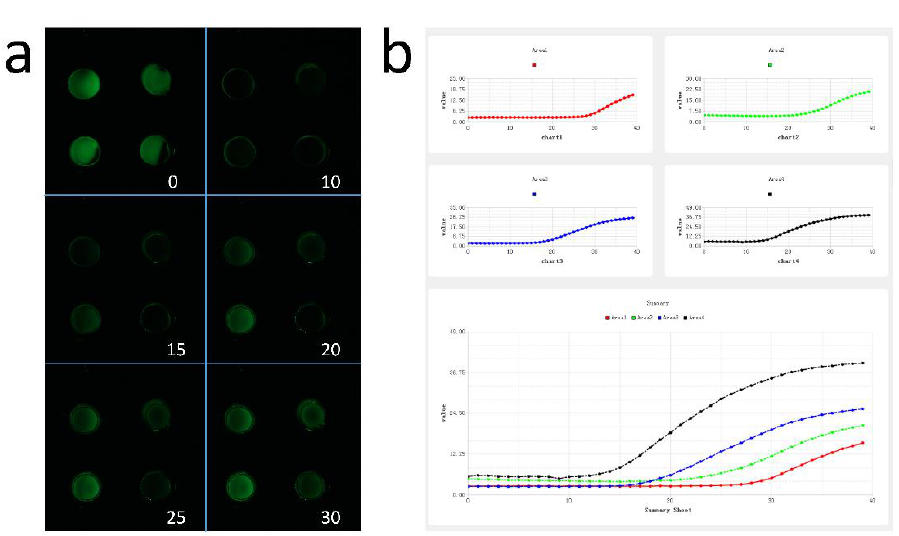
Figure 4. Fluorescence imaging of PCR and results of the software analysis. ( a ): fluorescence images in the 0th (before heating), 10th, 15th, 20th, 25th and 30th cycles. The fluorescence intensity of the stain at room temperature is very strong. The fluorescence intensity of the sample at room temperature before the reaction does not show the concentration of the target gene. ( b ): script processing of the fluorescence imaging.